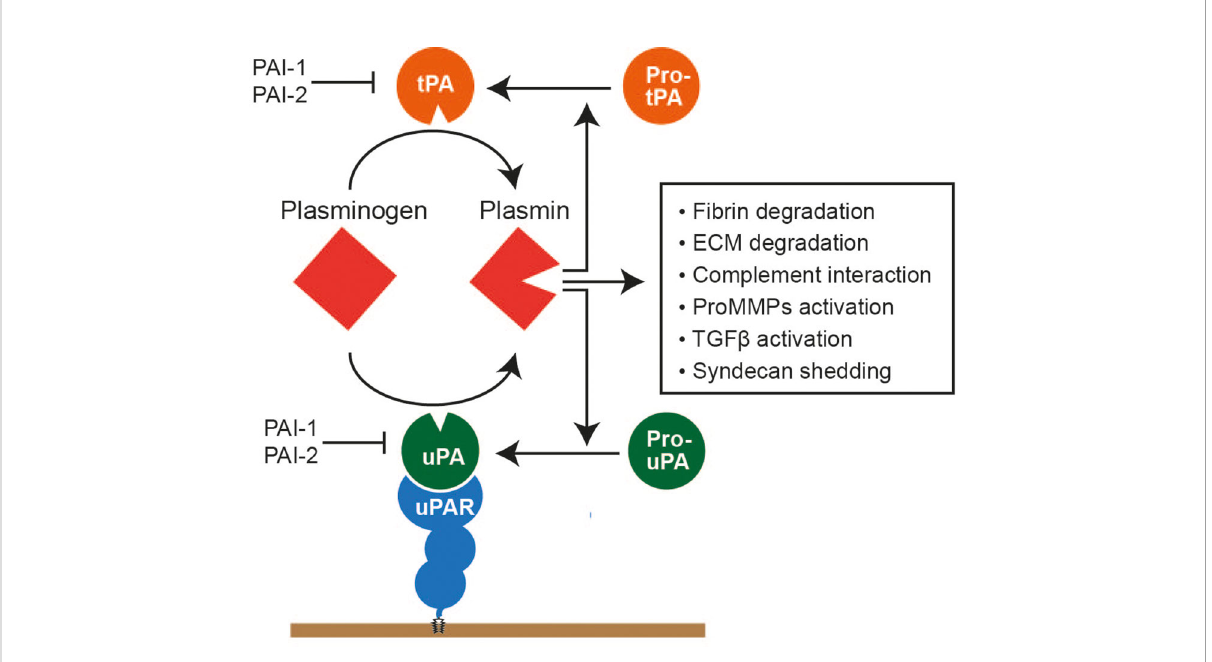
FIGURE 3 Plasmin system. Plasminogen is a precursor form of plasmin, mainly produced in the liver and present in the plasma at approximately 150 – 200 m g/ml. Plasminogen is activated by either a tissue plasminogen activator (tPA) or urokinase plasminogen activator (uPA). uPA is bound to the glycosylphosphatidylinositol-anchored uPA receptor and activates plasminogen on the cell surface. tPA and uPA are also produced as precursor forms, and activated plasmin can activate these activators. Activated plasmin can degrade cross-linked fi brin and various ECM components, interact with the complement system to facilitate complement cascade, activate proMMPs, activate the precursor form of TGF b , and cause syndecan